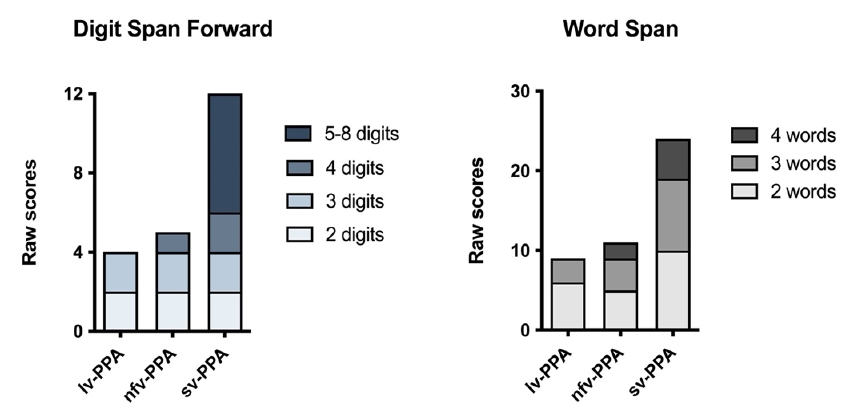
Figure 2. Raw scores on the Digit Span Forward and Word Span tests. The gradient colours/shading within the bar charts represent the gradient levels of difficulty (i.e., Digit Span: raw scores at the 2–, 3–, 4–, and 5–8-digit item levels; Word Span: raw scores at the 2–, 3–, and 4–word item levels).